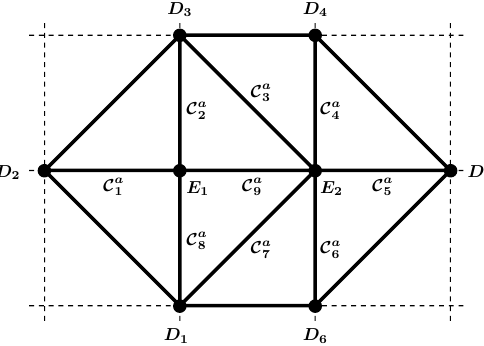
Figure 18: Resolution (a) of the beetle geometry, with all the curves